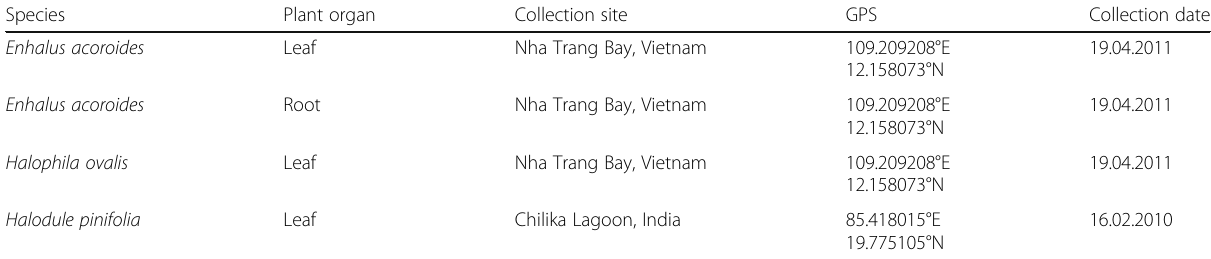
Table 1 Seagrass species and information about collection sites